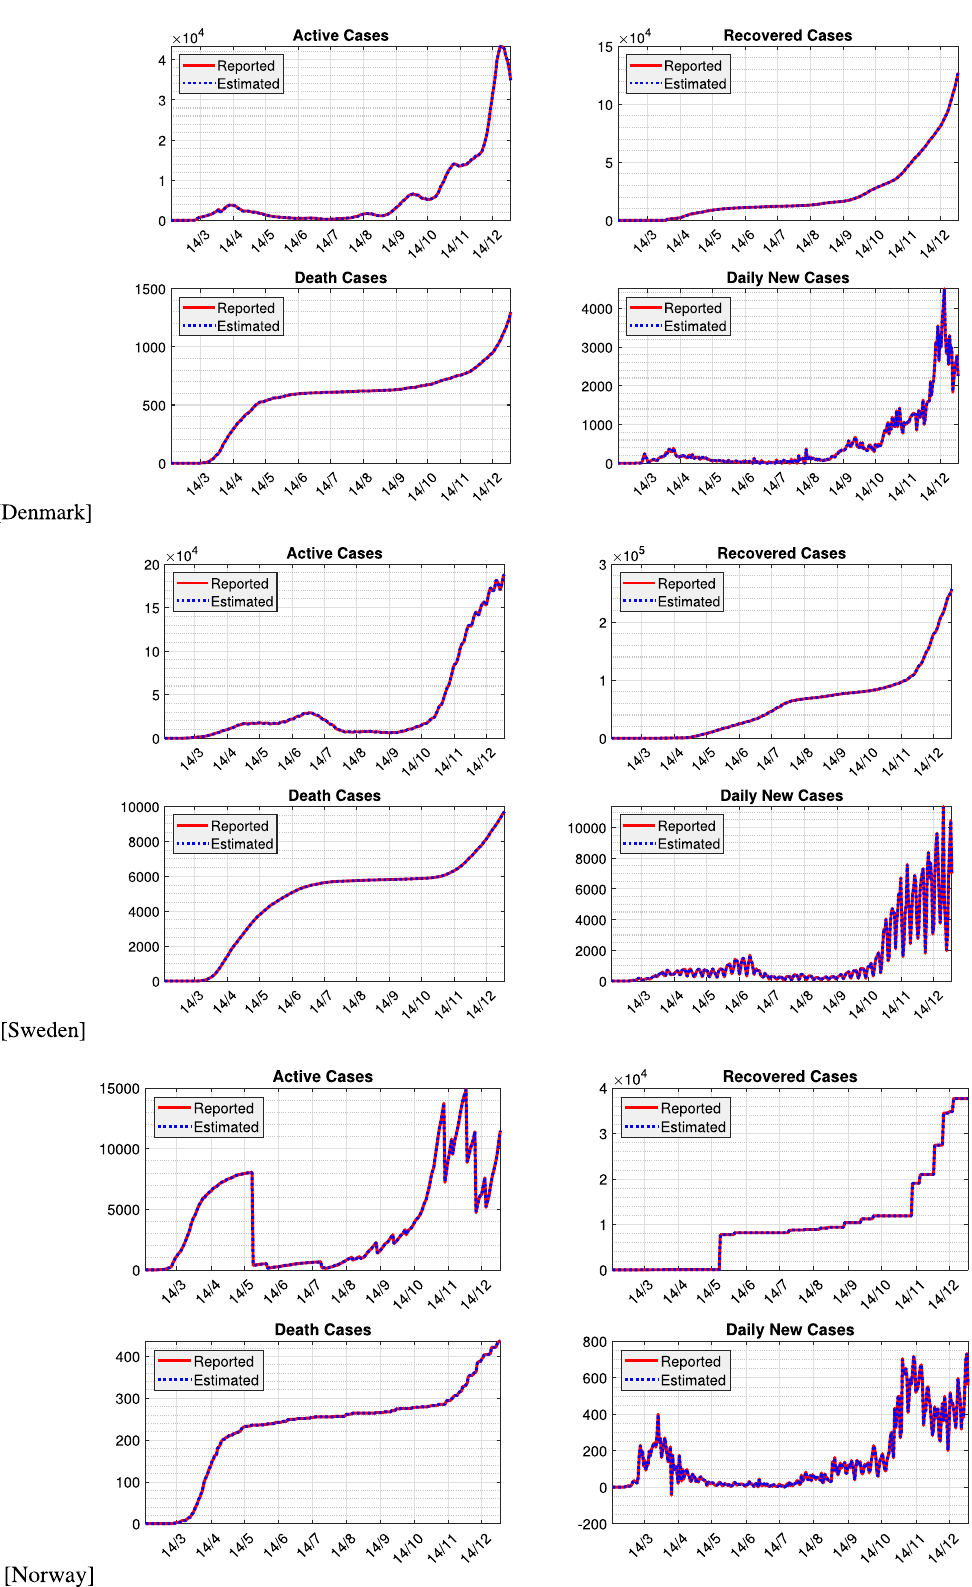
Figure 1. Comparison between reported and estimated cases for active (I), recovered (R), death (D), and daily new cases (E) from the three Scandinavian